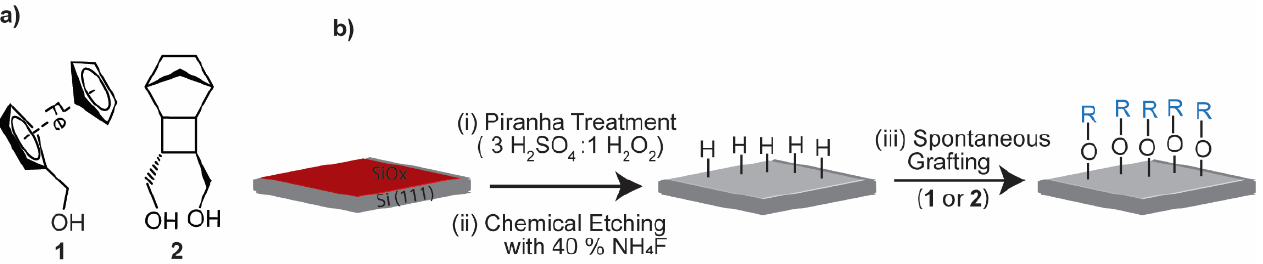
Figure 1. Schematic of the modification of the Si–H surfaces with OH-terminated molecules 1 and 2. ( a ) Structure of the monolayer-forming molecules. ( b ) Schematic of the surface functionalization process: ( i ) cleaning organic contamination by Piranha solution; ( ii ) SiOx etching with ammonium fluoride solutions; and ( iii ) spontaneous grafting of OH-terminated molecules to the Si–H surface with formation of covalent Si–O–C bonds.